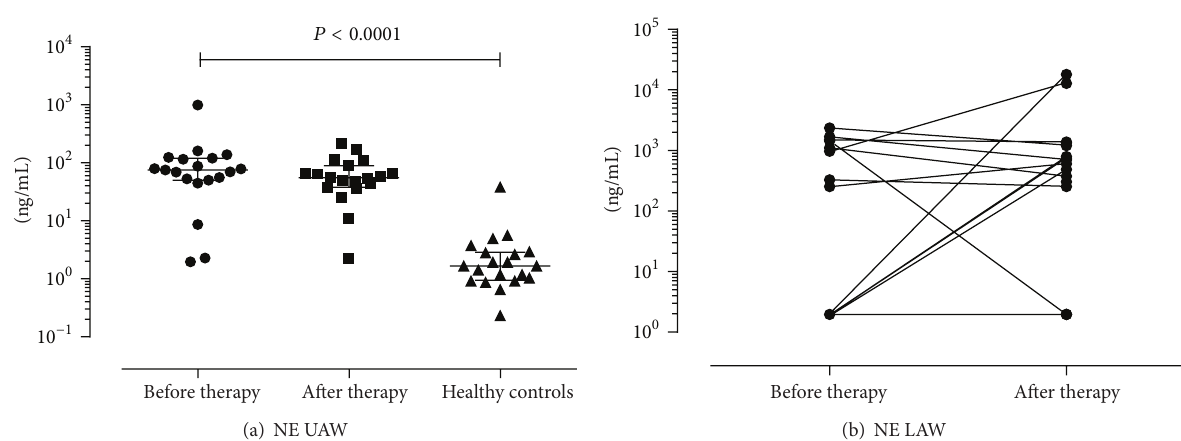
Figure 3: Changes of NE. Levels decreased in the UAW (a) after IV-antibiotic therapy. NE was statistically significantly lower in healthy controls compared to CF patients ( 𝑃 < 0.0001 ). In the LAW median levels increased after therapy, but five of seven matched pairs diminished after therapy (b).